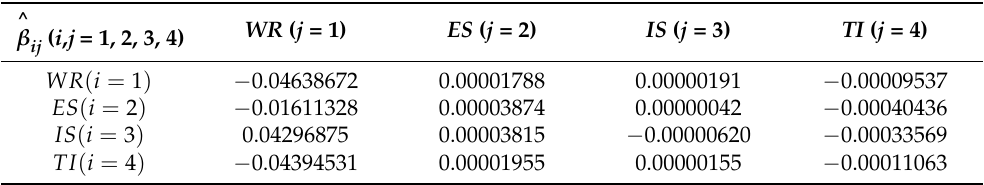
Table 3. Related parameters of GLV model in Beijing